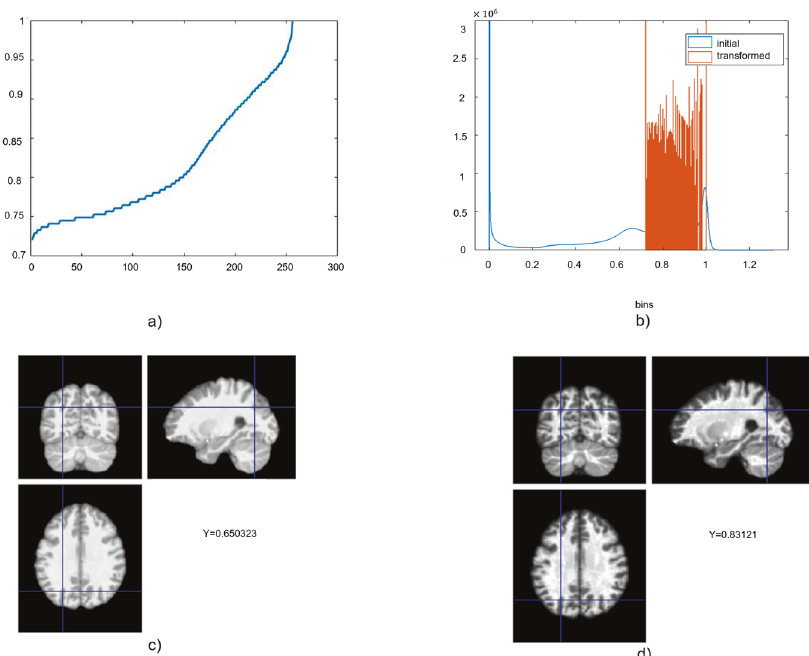
Fig. 1 Histogram equalization to adjust the intensity values. Representation of a the discretization function and b the initial intensities and the adjusted intensities using histogram equalization. The brain MRI in SPM12 for the c initial MR image and d transformed MR image using the histogram equalization.